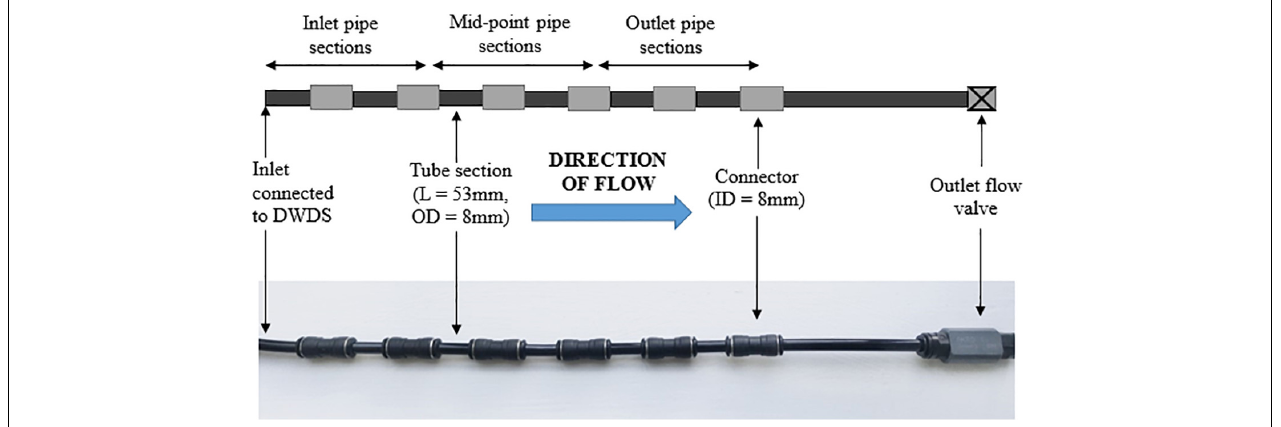
FIGURE 1 | Illustration of the biofilm monitoring device (BMD), including tube sections, connectors and a flow valve on the BMD outlet. L, length; OD, outside diameter; ID, inner diameter. BMD diagram is an illustration, and does not show the full number of tube sections used in an